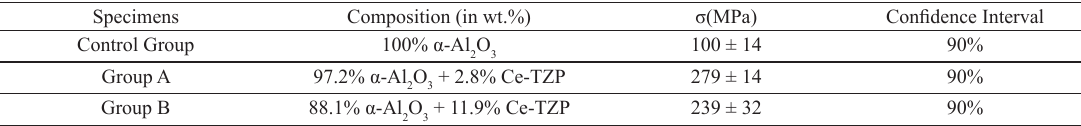
Table 2. Fatigue strength limits (σ) with the Modified Staircase Method for monolithic alumina (control group) and composites (groups A and B). Specimens Composition (in wt.%)